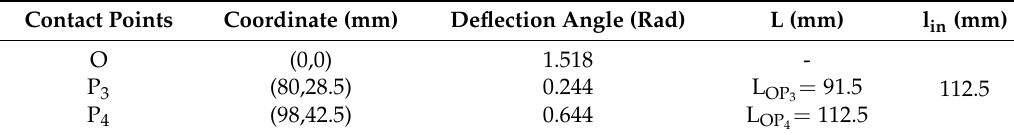
Table 5. Contact information about position